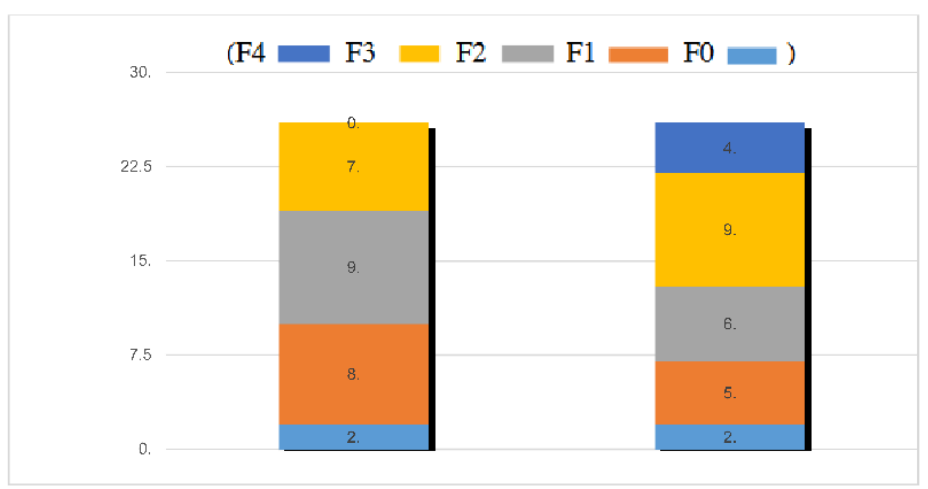
Figure 2. Fibrosis changes in 26 patients undergone a second liver biopsy. The first column indicates the number of patients with different fibrosis stages at baseline, the second the correstonding numbers at the follow up liver biopsy.